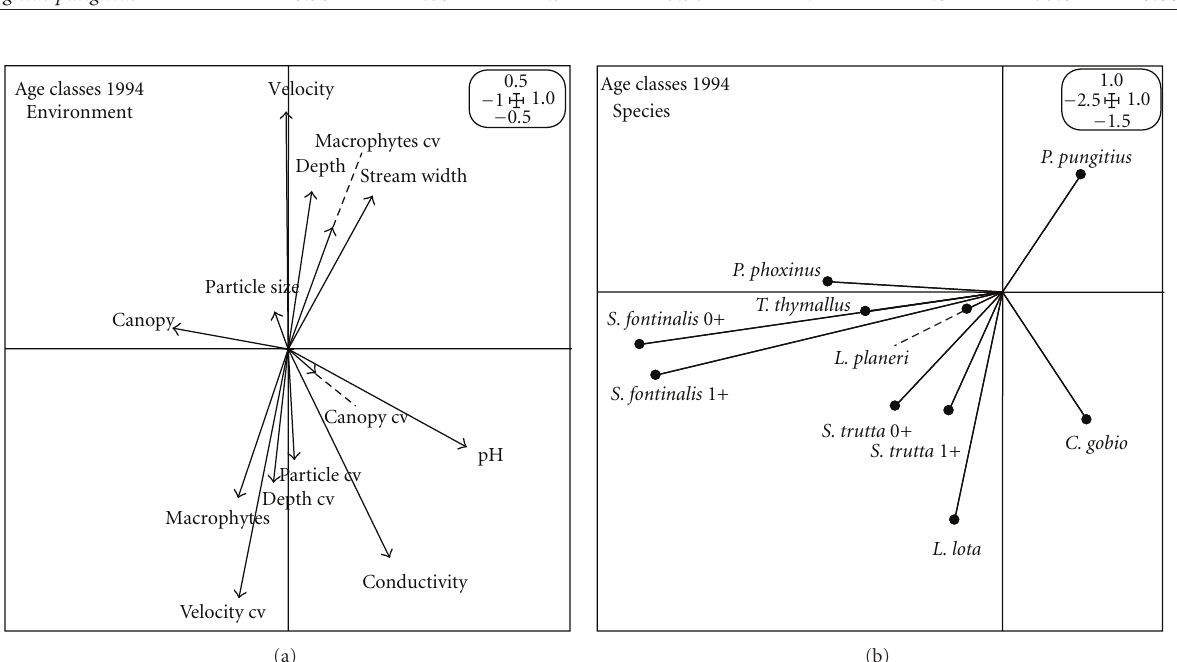
Figure 2: Environmental (a) and species (b) vectors on the first factorial plane of the OMI analysis. Analysis was based on the 1994 data, with the age classes of brown trout ( Salmo trutta ) and brook trout ( Salvelinus fontinalis ) shown